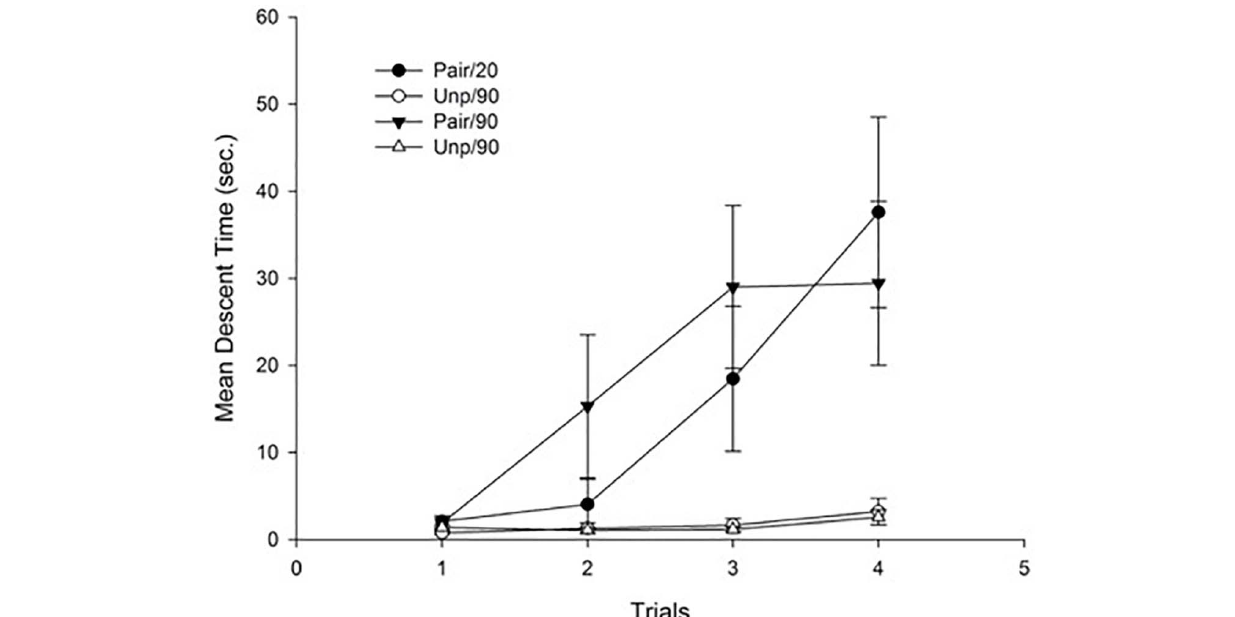
FIGURE 3 | Mean descent latency for conditioning trials as a function of Groups. Pair: Paired; Unp: Unpaired. Error bars represent SEMs.